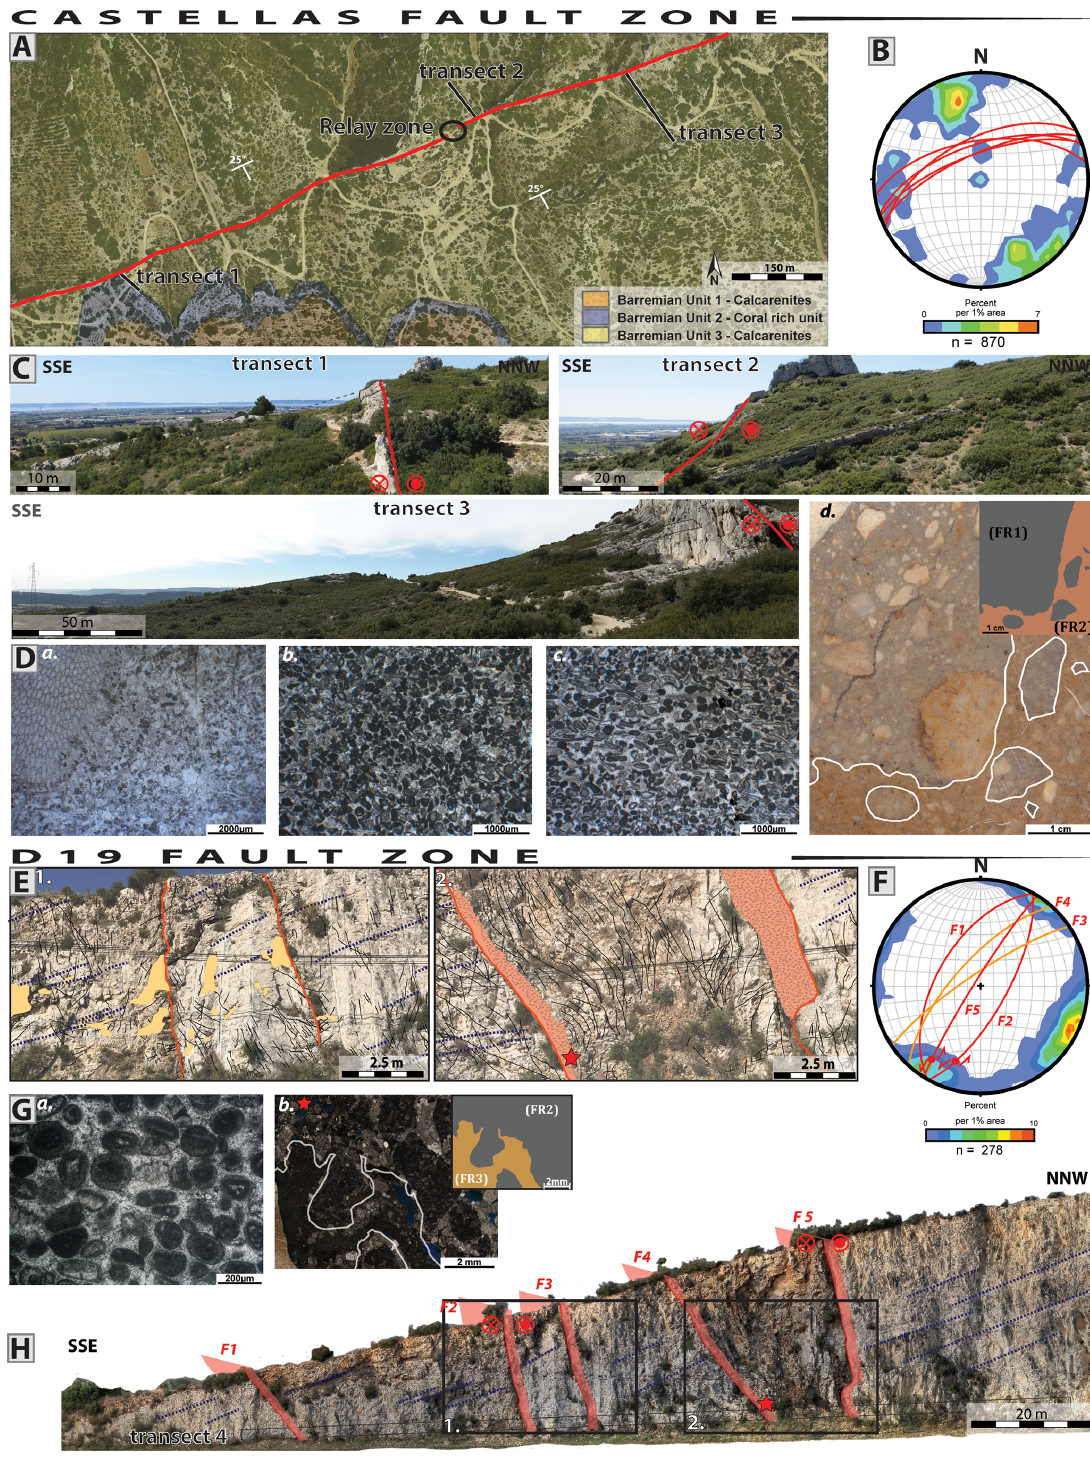
Figure 2. (A) Castellas Fault map on aerial photo with position of the studied transects and the relay zone; (B) stereographic projection of poles to fractures (density contoured) and faults (red lines) (Allmendinger et al., 2013; Cardozo and Allmendinger, 2013); (C) Photos of transects 1 to 3. (D) Photomicrographs of carbonate host-rock facies: (a) transect 1 coral-rich unit, (b) transect 2 calcarenites, (c) transect 3 calcarenites, and (d) fault rocks 1 and 2 (FR1 and FR2). (E) Pictures of D19 outcrop. (F) Stereographic projection of poles to fractures (density contoured), set 1 faults (orange line) and set 2 faults (red line). (G) Photomicrographs of (a) host rock facies and of b fault rocks (red stars on the pictures); (H) D19 outcrop including the five faults F1 to F5.